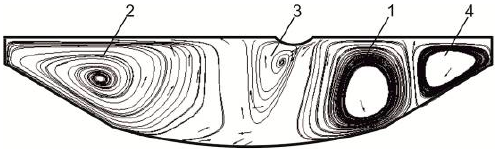
Figure 6. The trajectories of flows in the bath vertical section along the Y axis with allowance made for the heat-gravitational convection.